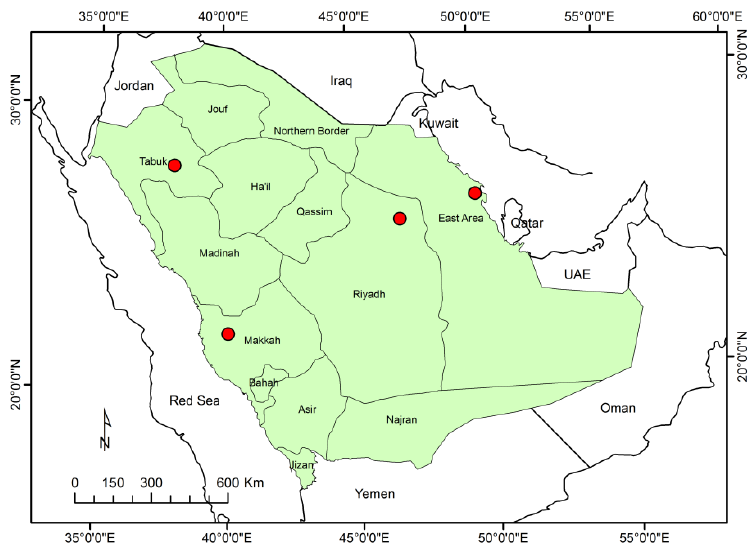
Figure 1. Selected study areas in Saudi Arabia.